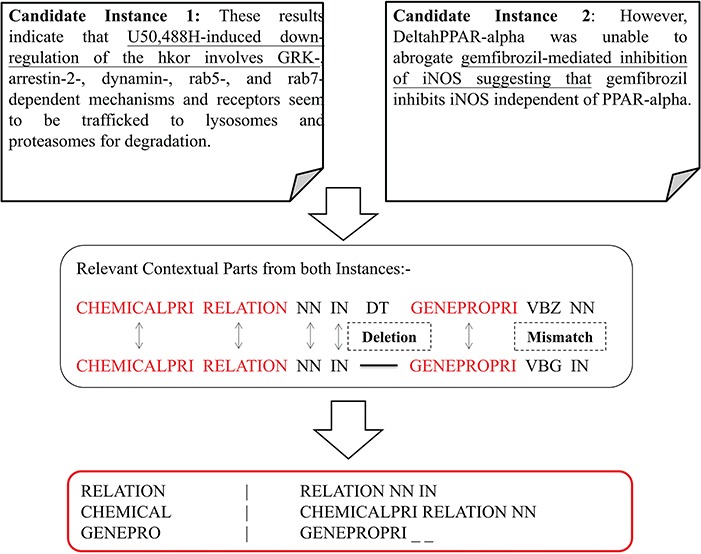
Context identification and prospective alignment of candidate instances.